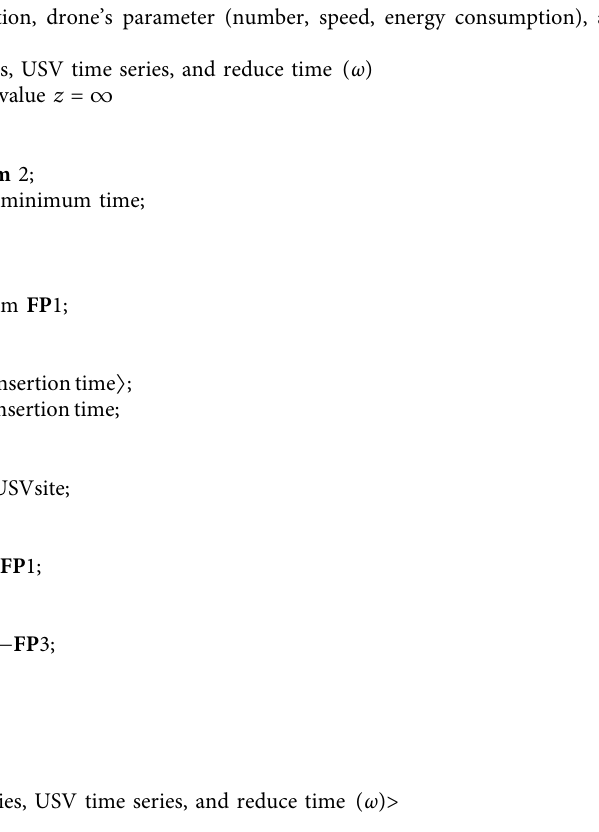
A LGORITHM 1: Te MFSDCP heuristic